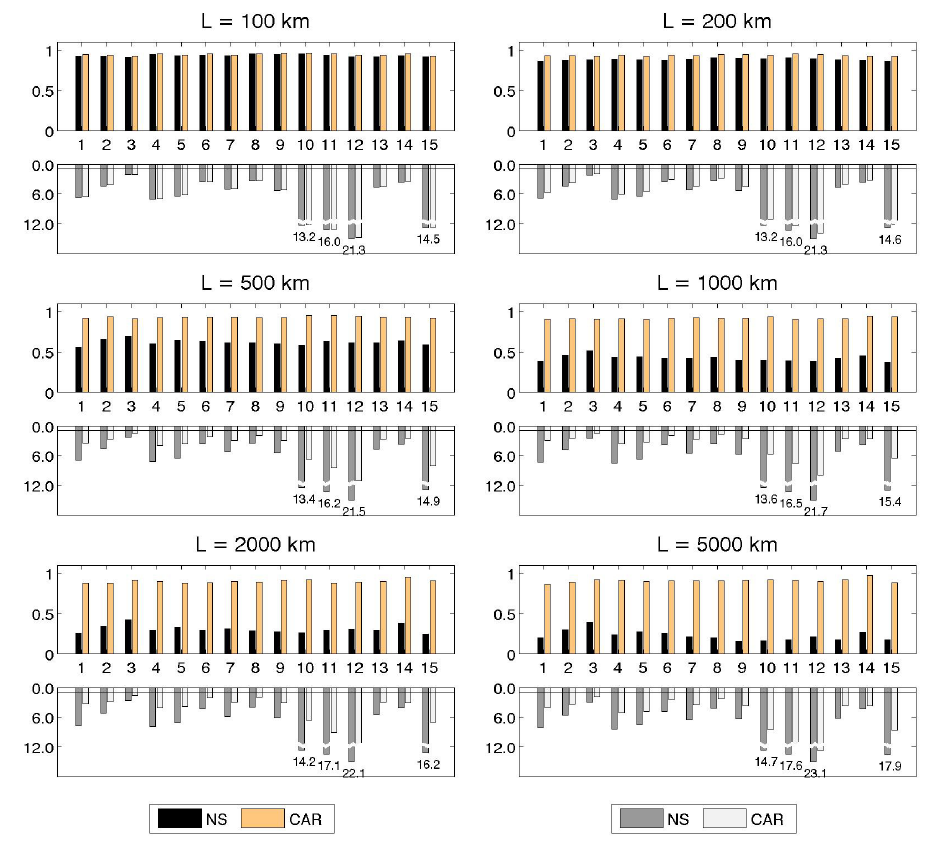
Fig. 9. Success Rate (top panels) and Learning Ratio (bottom panels) for all CO source categories for different values of L . See Fig. 2 for definition of source category